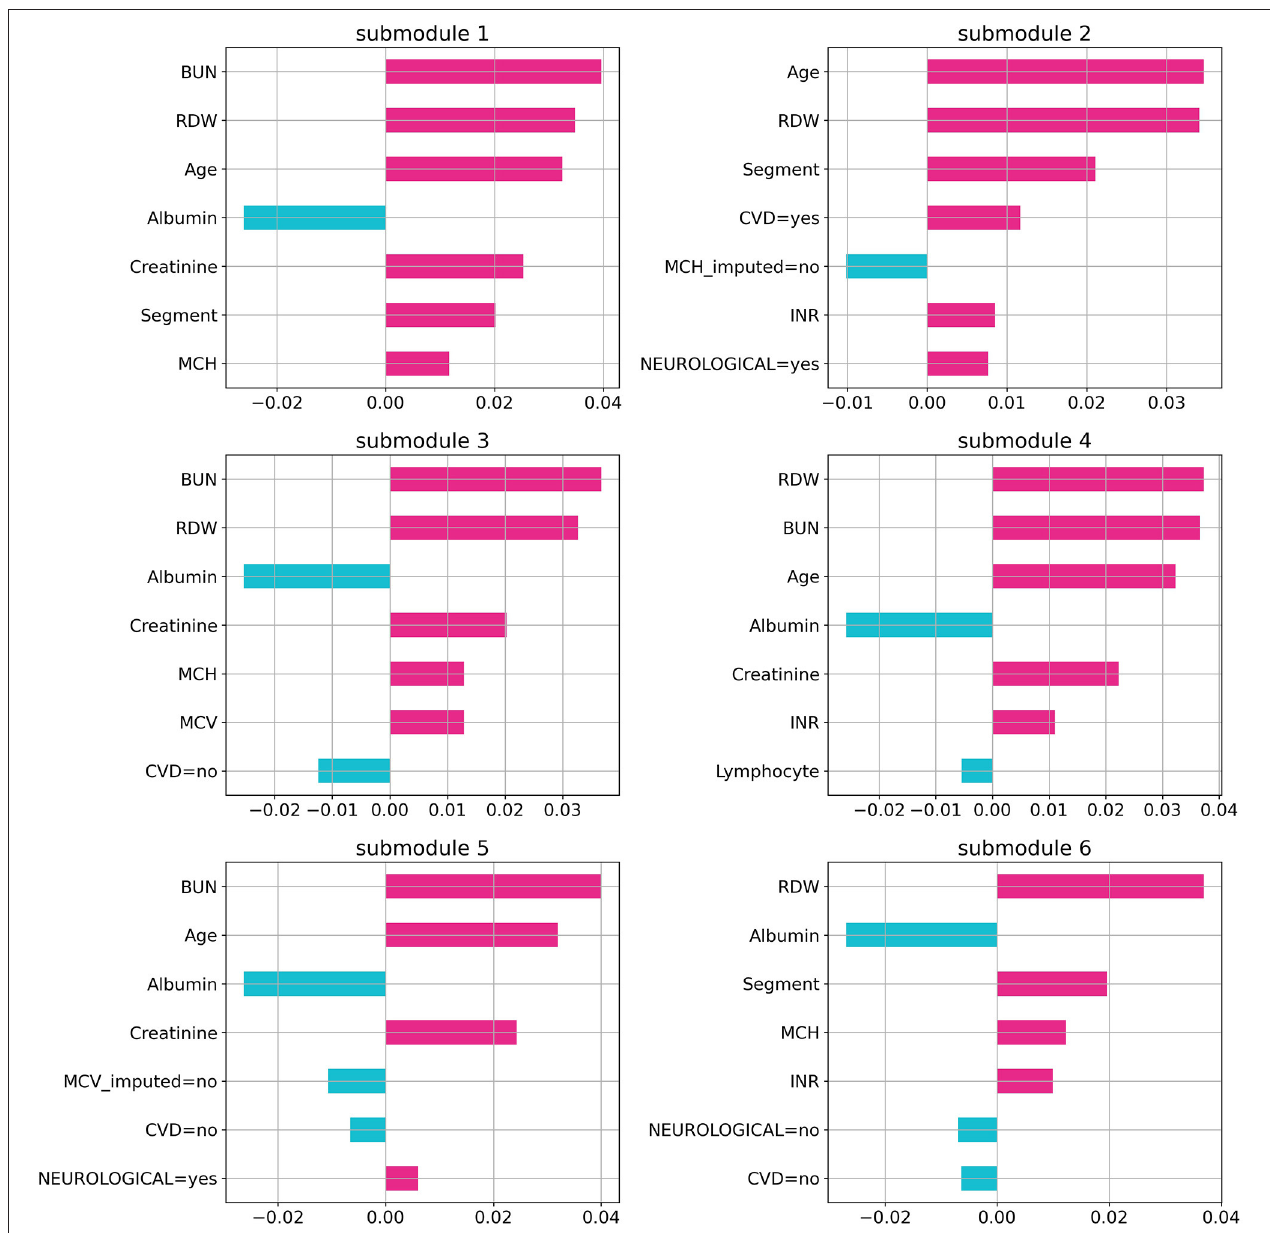
FIGURE 2 | Feature importance in random forest model. The importance of the random forest features using local interpretable model-agnostic explanation submodular-pick with six submodules. Each submodule is related to a patient subpopulation (six subpopulation in this case) and represents decision criteria for them in the model. Negative values (blue) indicate favorable parameters suggesting a better prognosis, and positive values (red) indicate unfavorable parameters suggesting a worse